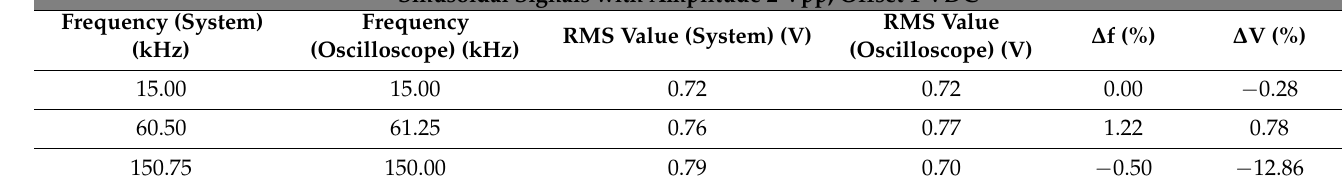
Table 3. Comparisons between the calibrated oscilloscope and the FPGA-based system measurements for sinusoidal signals with amplitude of 2 Vpp with 1 VDC offset value, for signal frequencies of 15 kHz, 60 kHz and 150 kHz.